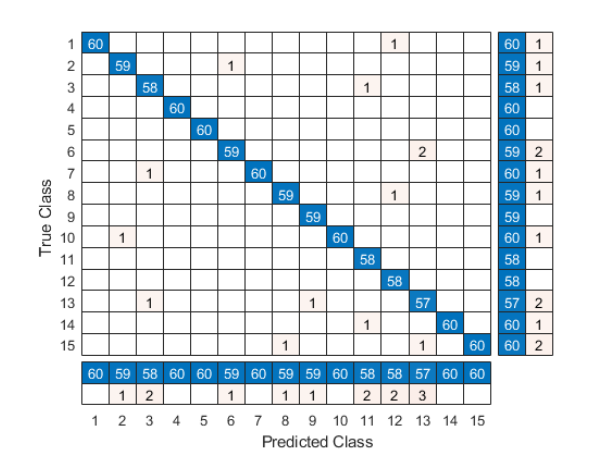
Figure 9. kNN Classifier Confusion Matrix: A confusion matrix summarizes the performance of a classification algorithm. It gives a better idea of what your classification model is getting right and what types of errors it is making. Classification accuracy alone can be misleading because we have more than two classes in our